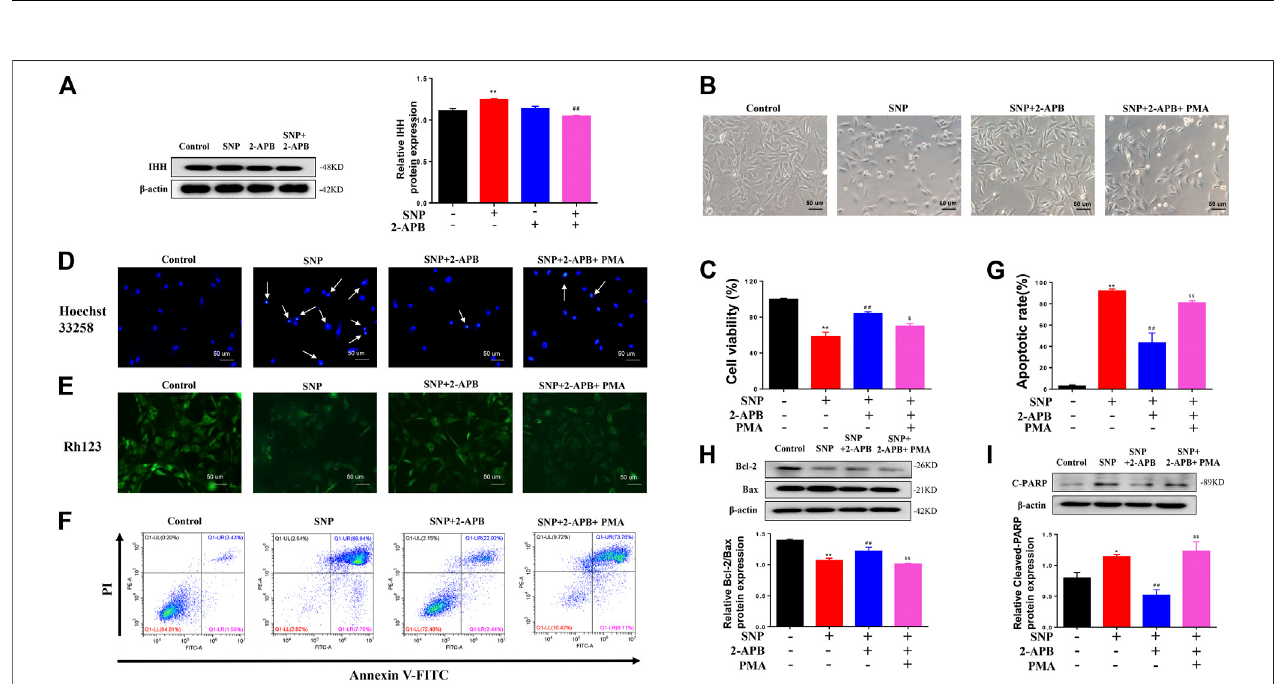
FIGURE 5 | IHH activated by PMA reverses the protective effects of 2-APB on SNP-induced chondrocyte apoptosis (A) Western blot analysis of 2-APB on SNP- induced IHH protein expression in chondrocytes ( n (cid:2) 3) (B) Morphology of PMA on SNP-induced chondrocytes (C) MTT assay of PMA on cell viability of SNP-induced chondrocytes ( n (cid:2) 6) (D) Hoechst 33,258 stain of PMA on SNP-induced chondrocyte chromatin of the nucleus ( n (cid:2) 3) (E) Rh123 stain of the in fl uence of PMA on mitochondrialmembranepotential( n (cid:2) 3) (F) AnnexinV-FITCandPIstatinofSNP-inducedchondrocyteapoptosistreatedwithPMA( n (cid:2) 3) (G) Quantitativeanalysis ofchondrocyteapoptosisrate( n (cid:2) 3) (H) WesternblotanalysisofSNP-inducedBcl-2/BaxratiotreatedwithPMA( n (cid:2) 3) (I) WesternblotanalysisofSNP-inducedcleaved PARP protein expression treated with PMA ( n (cid:2) 3). Chondrocytes were seeded in 6-well plates cultured for 24 h, then treated with 2-APB (100 μ M), SNP (0.5 mM) and PMA(4 μ M)for12 h.Valuesarepresentedasmean ± SEM.* p < 0.05, ** p < 0.01,comparedwiththecontrolgroup; ## p < 0.01,comparedwiththeSNPgroup; $ p < 0.05, $$ p < 0.01, compared with the SNP+2-APB group.